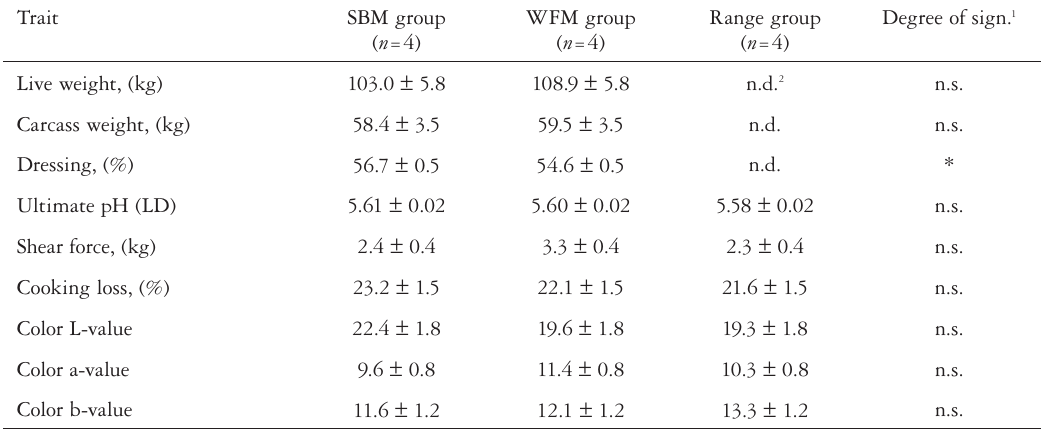
Fig. 3. Temperature decline (mean values and fitted regression curves) in M. longissimus (LD) from reindeer from two feeding treatments; SBM (feed mixture based on soybean meal protein; n =4) and WFM (feed mixture based on fish meal protein; n =4) included in the study, measured at 1, 2, 3, 4, 5, 6, 7, 8, 10, 12 and 24 h post mortem Table 5. Carcass and meat quality characteristics in M. longissimus (LD) in reindeer from three different feeding treat- ments; SBM (feed mixture based on soybean meal protein), WFM (feed mixture based on fishmeal protein) and grazing free ranging animals included in the study (least-squares means and standard errors).